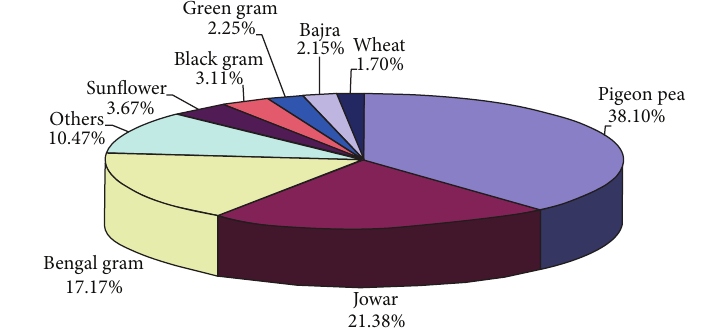
Figure 2: Cropping pattern of study area.